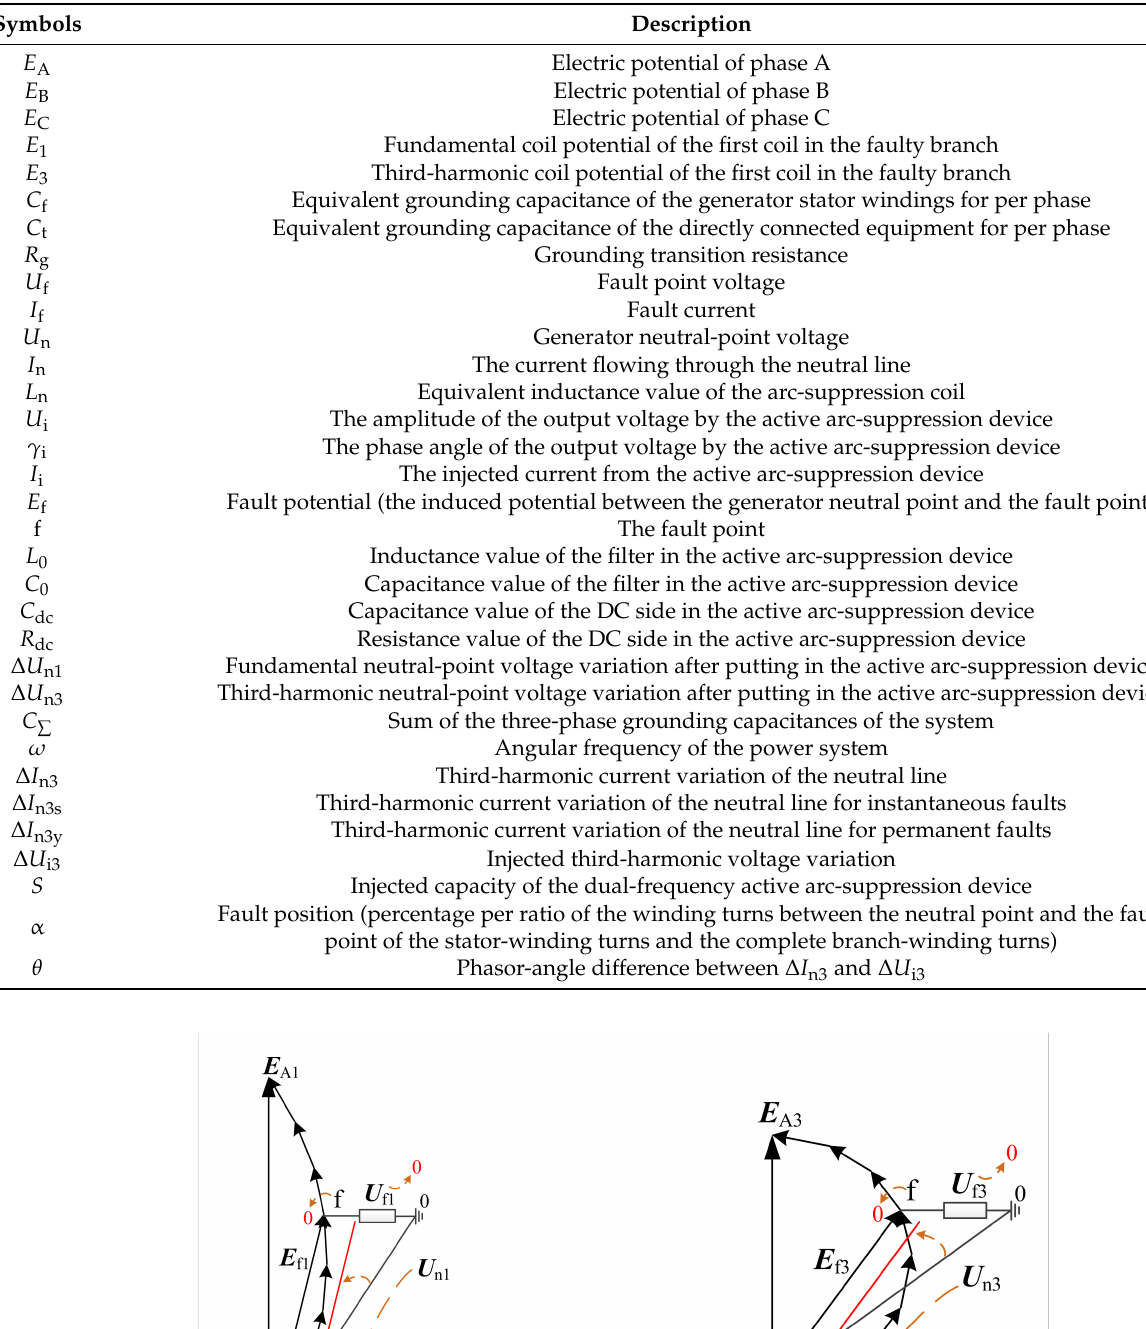
Table 1. Nomenclature table.